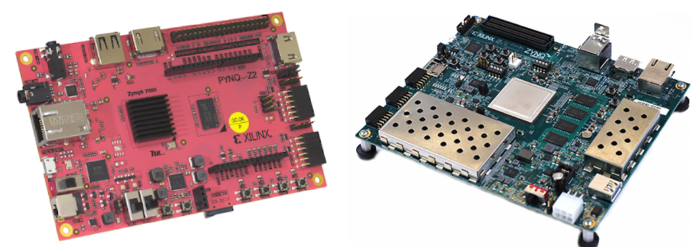
Figure 3. The Pynq-z2 ( left ) and ZCU104 ( right ) boards are the FPGA platforms used in the